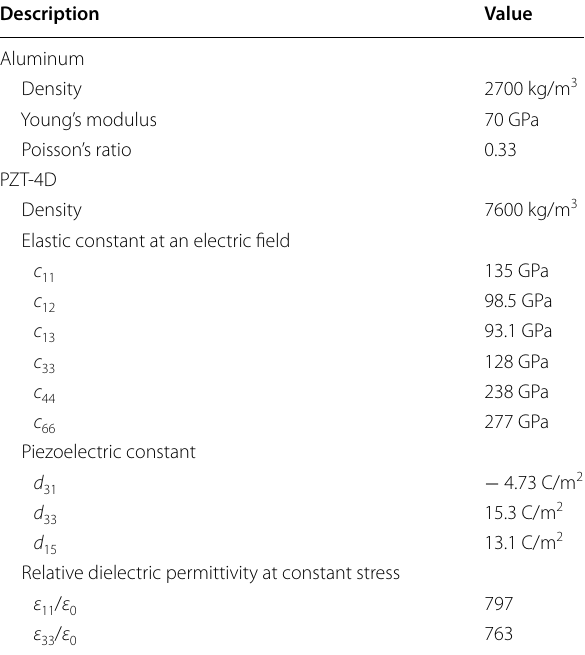
Table 1 Material properties of the aluminum and